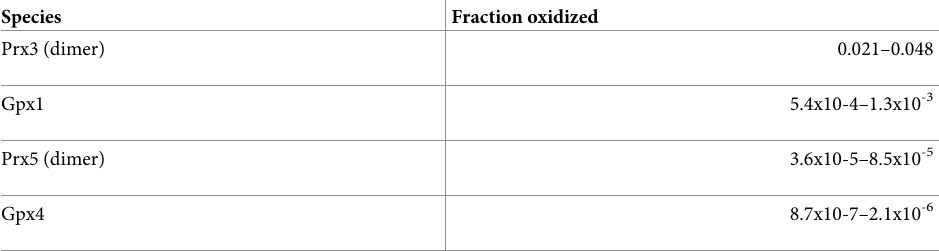
Table 4. Summary of fractional oxidation of major antioxidants in the network.